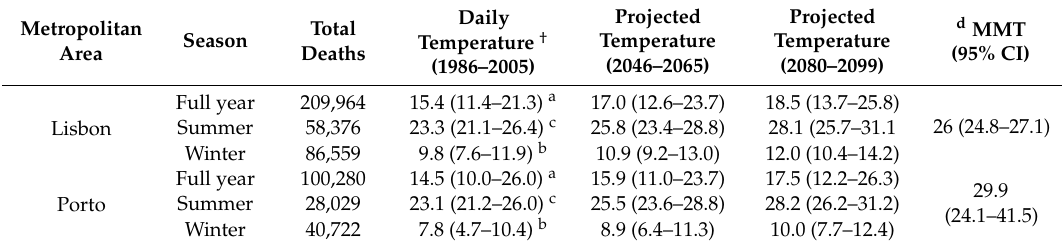
Table 1. Region-specific summary statistics of mortality from circulatory system diseases (CSD) and daily temperatures ( ◦ C), for the whole year, summer and winter months, for Portuguese metropolitan areas (Mean, IQR a ).